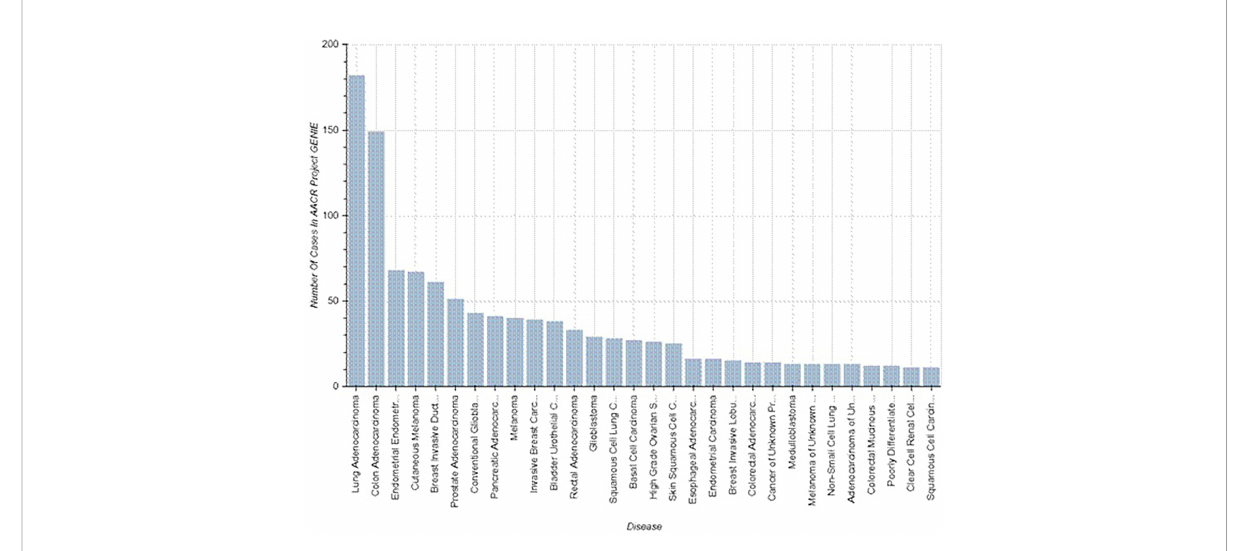
FIGURE 2 Known cases of malignancy associated with PTCH1 mutations (https://www.mycancergenome.org/content/alteration/ptch1-mutation/).